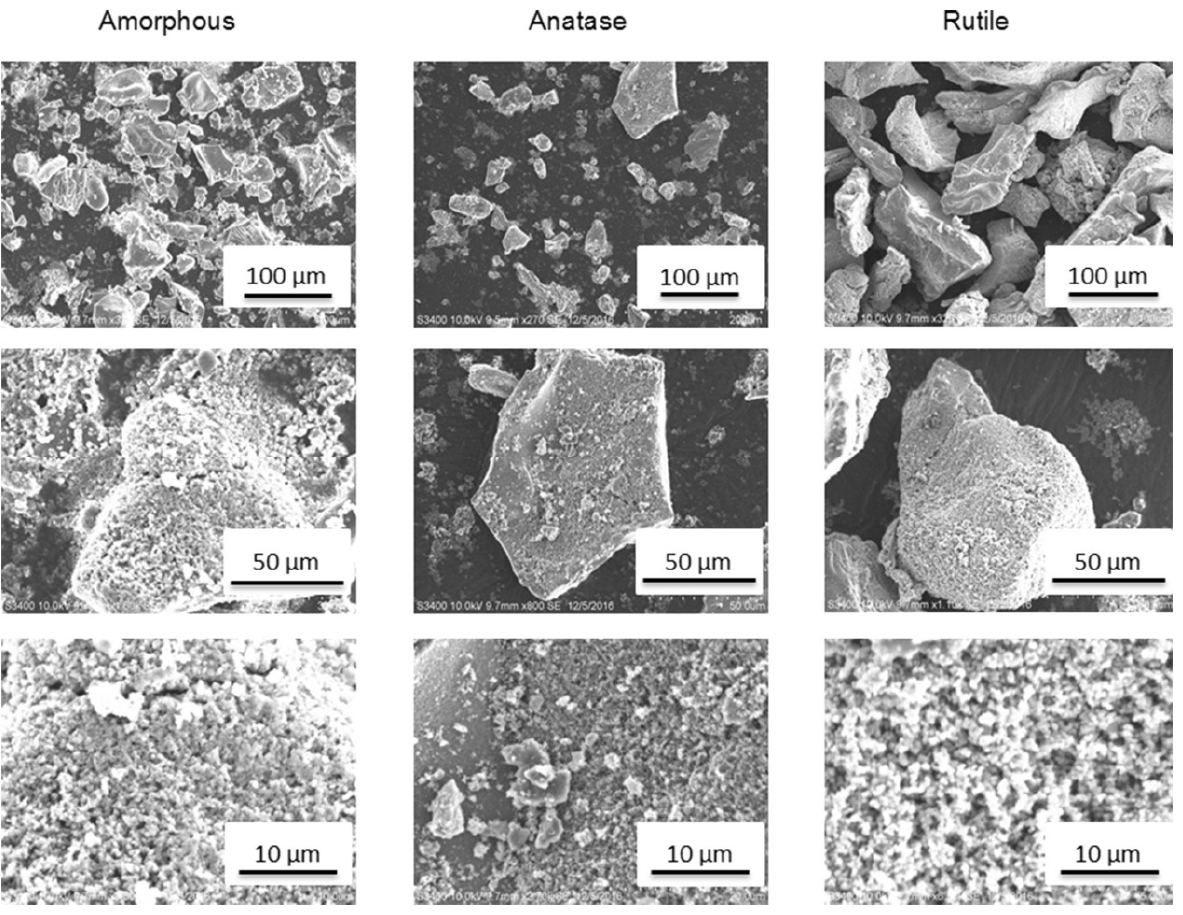
Figure 27. Micrographs (SEM, BSE) of SG TiO 2 various polymorph powders after synthesis. Reprinted with permission from [240]. Copyright 2019 Elsevier.